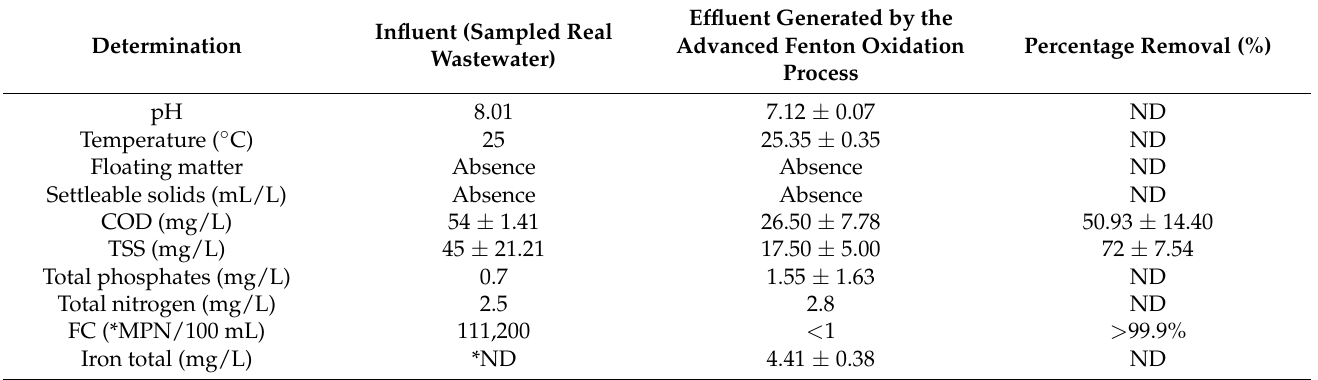
Table 1. Results of the physicochemical characterization of the influent and effluent generated by the advanced Fenton oxidation